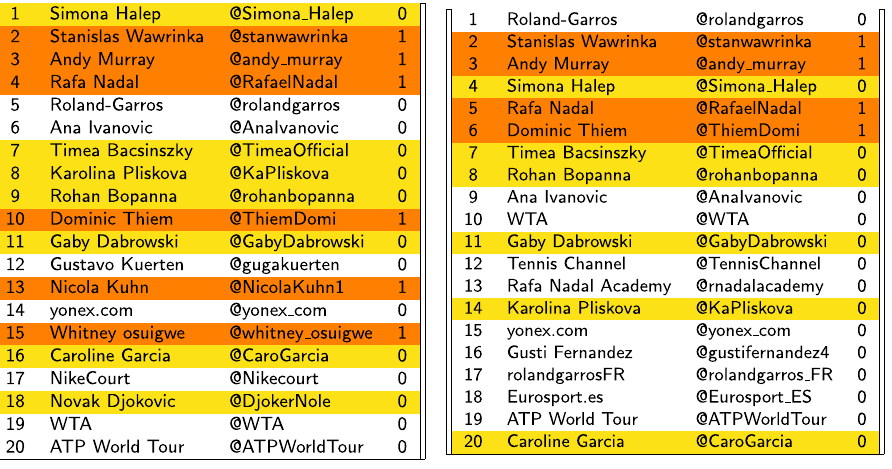
with other dynamically updateable algorithms. We found that temporal Katz centrality can identify accurately and quickly the emerging, new important nodes and that it worked particularly well in the US Open 2017 (UO17) collection.